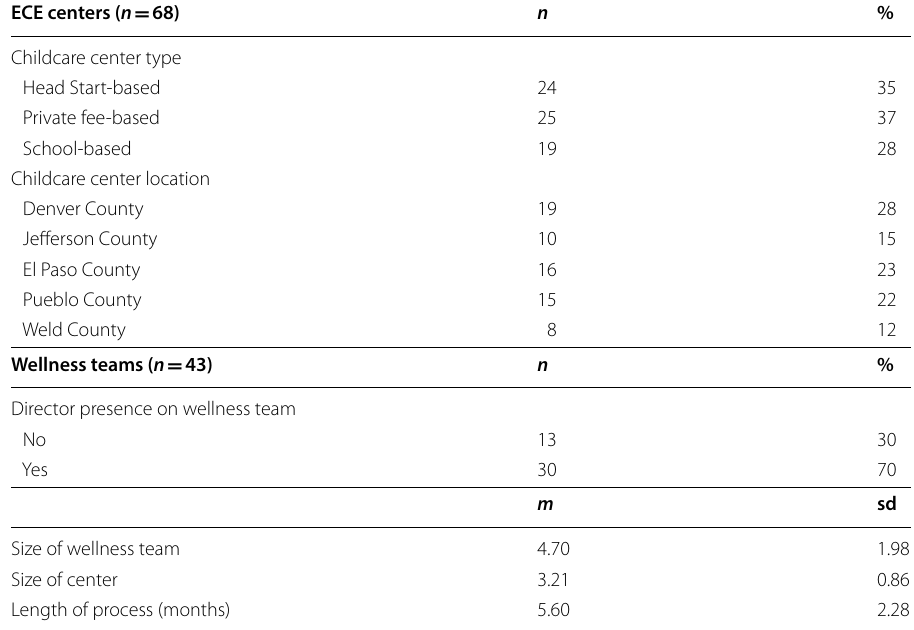
Table 2 Demographics ( n 43 wellness teams representing 68 ECE centers) = ECE centers ( n 68) =